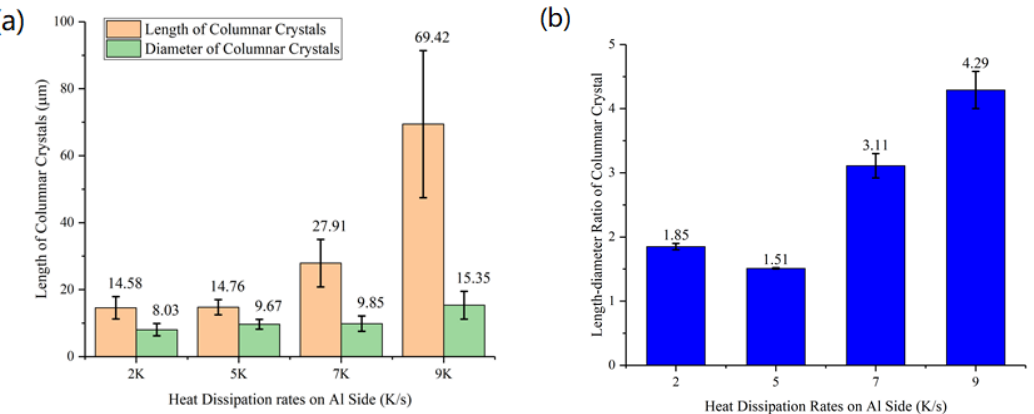
Figure 7. ( a ) columnar crystal length and diameter under four Al side heat dissipation rates (K/s) at 2 K/s, 5 K/s, 7 K/s and 9 K/s; ( b ) columnar crystal length-diameter ratio of Al-side heat dissipation rate (K/s) at 2 K/s, 5 K/s, 7 K/s and 9 K/s.